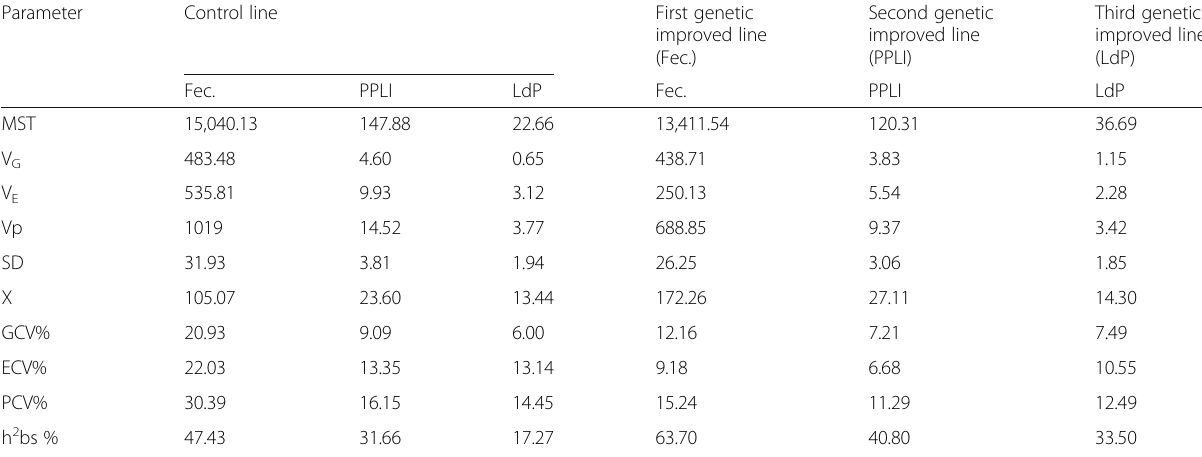
Table 3 Estimation of the important genetic parameters of quantitative traits included in the artificial index of C. montrouzieri among 12 generations of inbreeding Parameter Control line First genetic